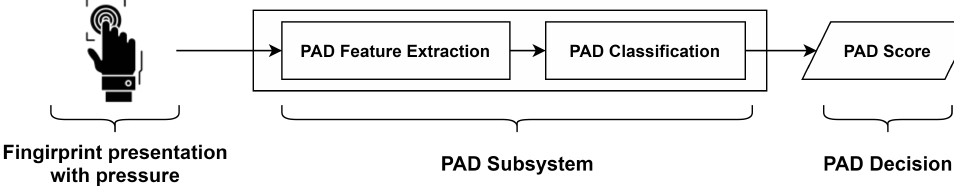
Figure 1. The segments of the generic PAD